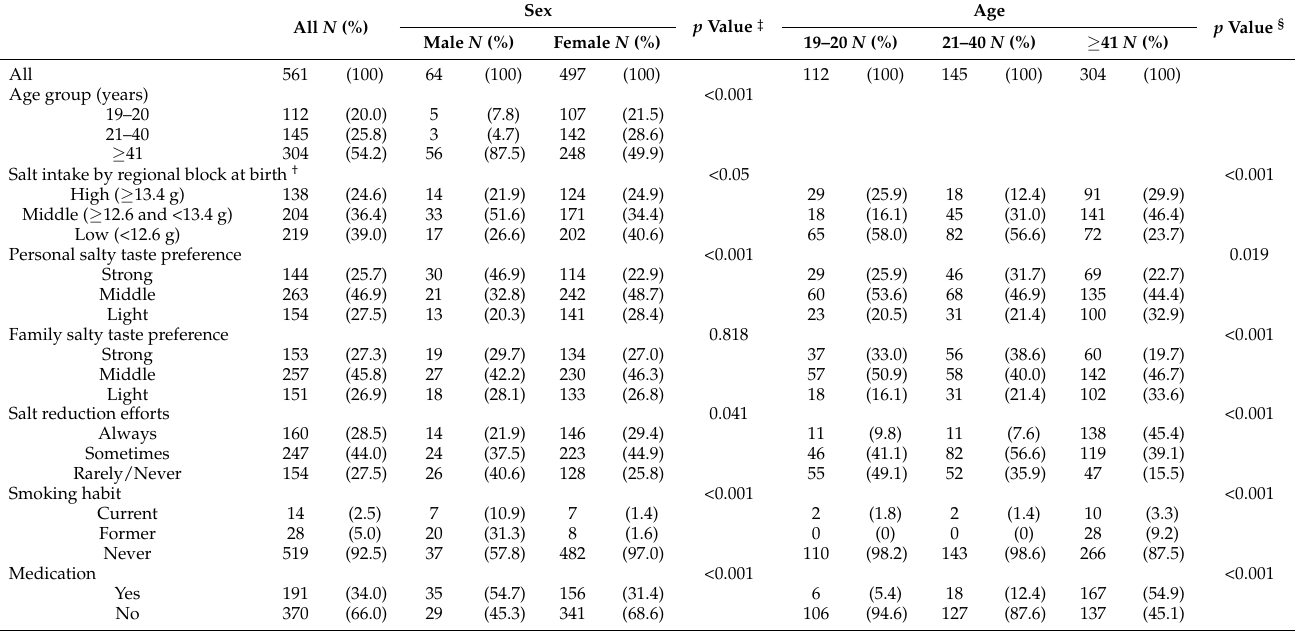
Table 2. Characteristics of the study participants according to sex and